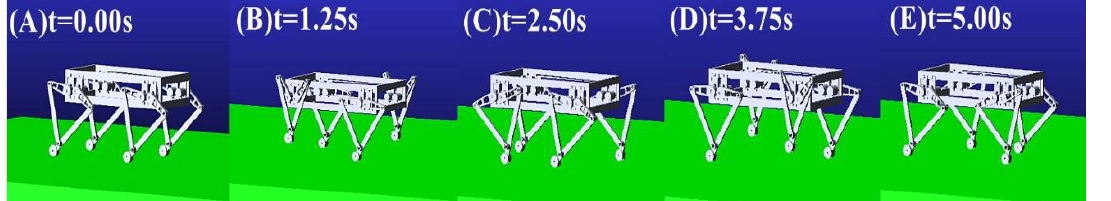
Figure 14. Schematic diagram of simulation process using fuzzy adaptive PID control system in a complete gait